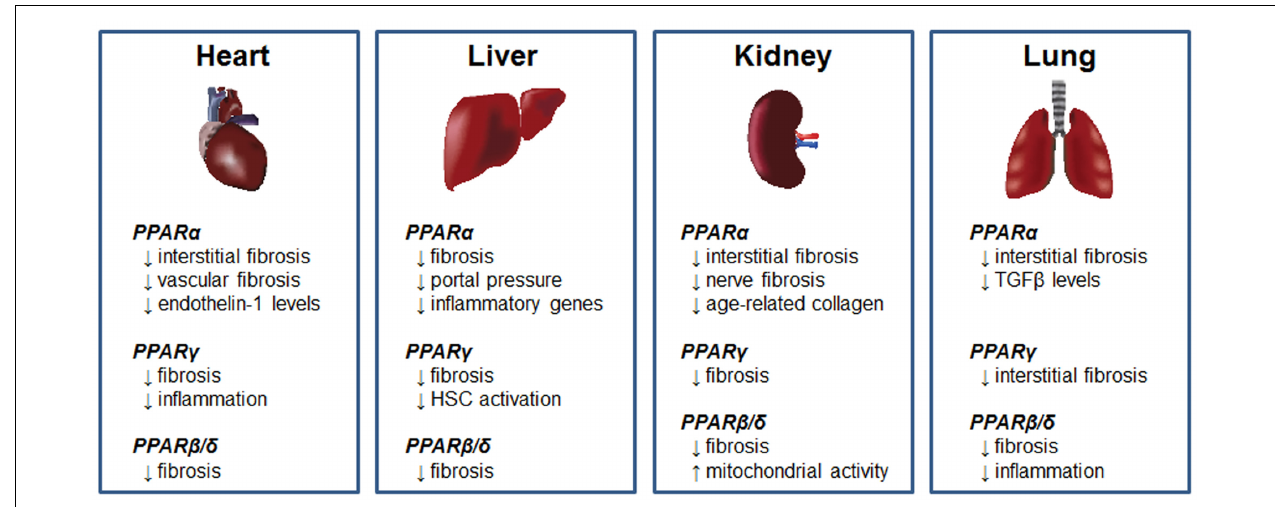
FIGURE 2 | Antifibrotic effects of PPARs. Summary of the antifibrotic effects of PPAR α , PPAR γ , and PPAR β / δ agonists in models of cardiac, hepatic, renal and pulmonary fibrosis.